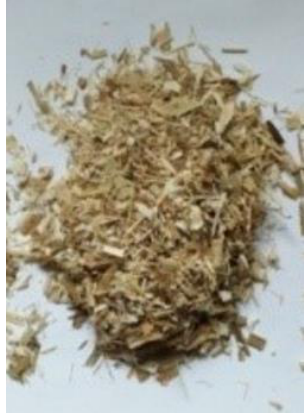
Figure 2. The crushed raw material.